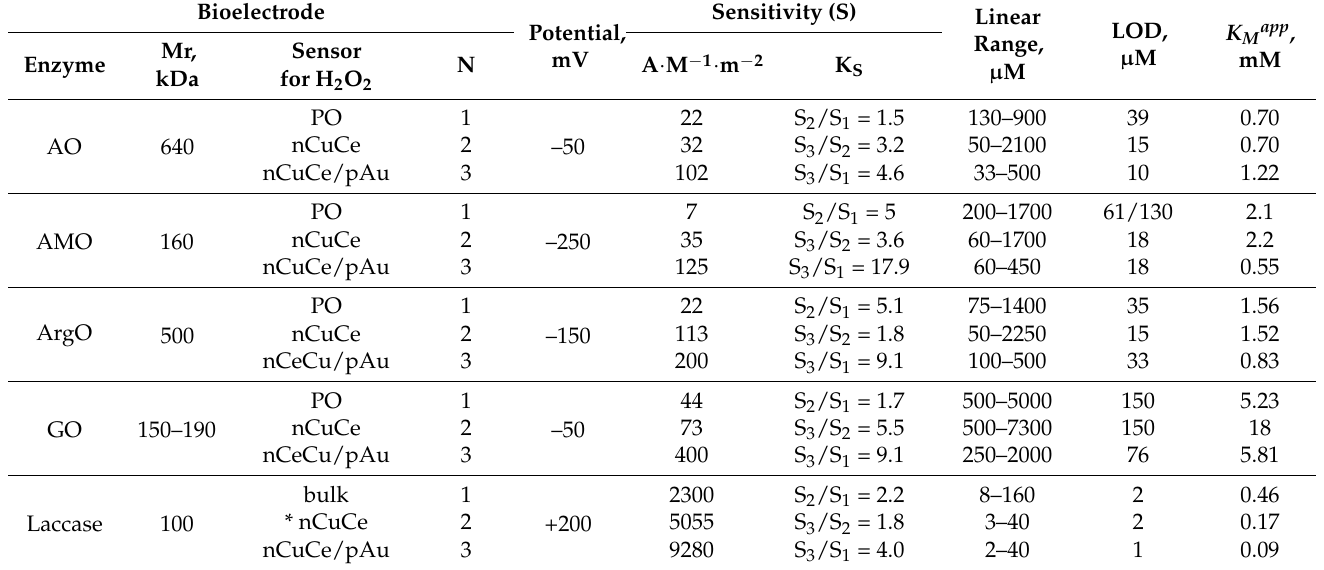
Table 1. Analytical characteristics of the constructed